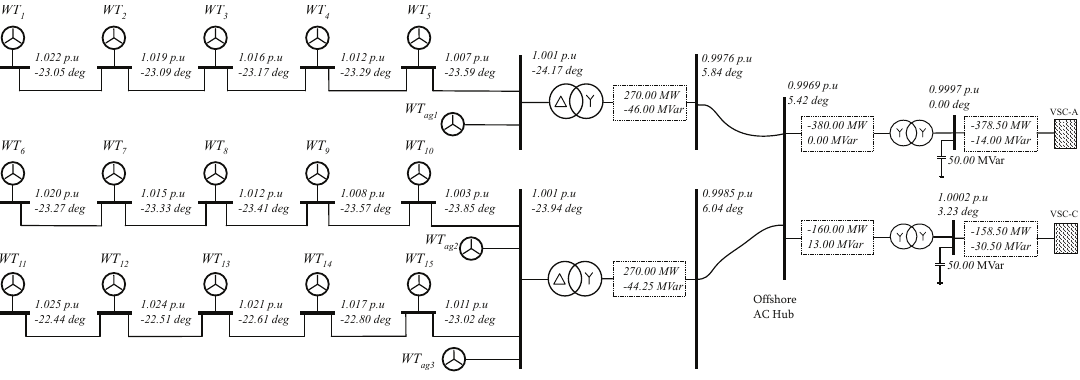
Figure 13. Steady-state voltage level within the wind power